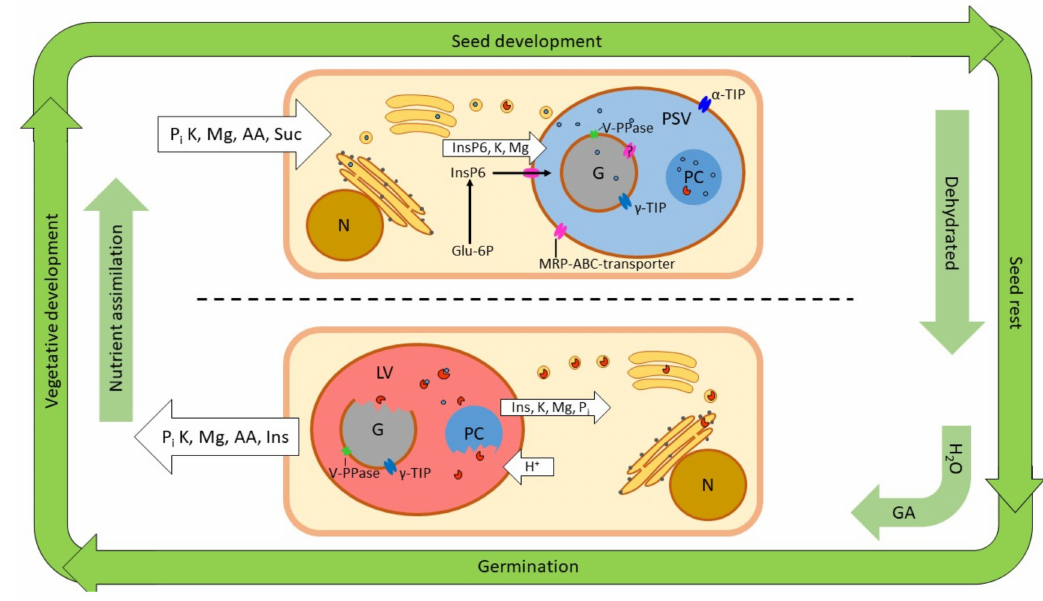
Figure 3. Events in a storage tissue cell in relation to the plant’s life cycle. Above the dotted line is a cell during seed development. Below it is a cell during germination. The organelles shown are the nucleus (N), with the attached rough ER and the golgi apparatus above. The protein storage vacuole (PSV) with neutral pH is indicated by the blue color, and the lytic vacuole (LV) with acidic pH is indicated by the red color. Only one vacuole is shown in each cell for graphic simplicity. The vacuoles contain the globoid (G) and the protein crystalloid (PC). Ion and molecule fluxes are indicated on the white arrows; phytate biosynthesis and transport is indicated during seed development. The blue dots are storage proteins, and the red circles missing a sector are